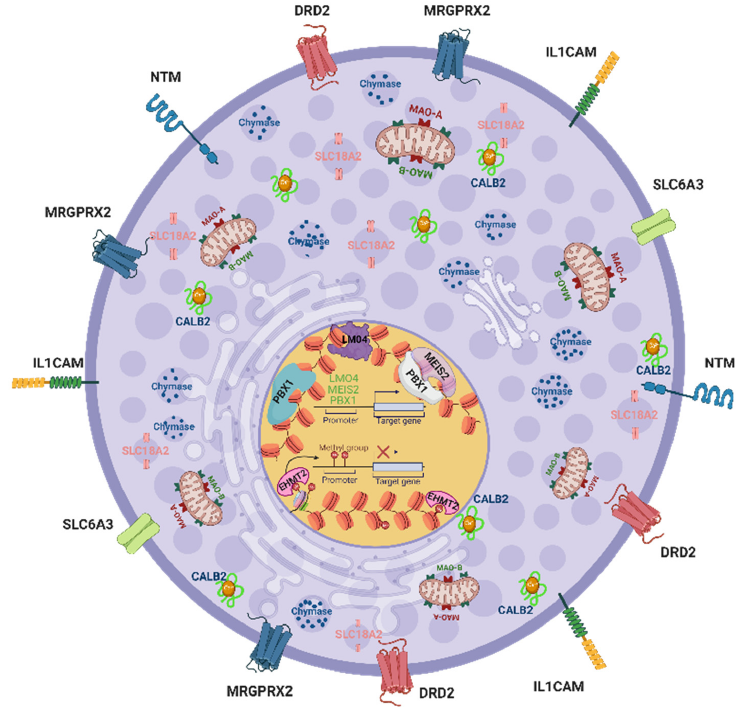
Figure 2. The nervous system-related genes covered in this review. A unifying element is their preferential expression in MCs in comparison to other myeloid cells. Depicted is the principal cellular localization of the following entities: DRD2, MAOA, MAOB, SLC18A2, SLC6A3, MLPH, RAB27B, RAB37, CALB2, L1CAM, NTM, LMO4, PBX1, MEIS2, and EHMT2. The genes MC chymase (CMA1) and MRGPRX2, expressed only by MCs and not by other constituents of the body (according to the com- prehensive FANTOM5 atlas), have been added for comparison. Abbreviations: CALB2 (Calbindin 2 or Calretinin), DRD2 (Dopamine Receptor D2), EHMT2 (Histone-lysine N-methyltransferase), L1CAM (Neural cell adhesion molecule L1), LMO4 (LIM domain transcription factor 4), MAOA (Amine oxi- dase (flavin-containing) A), MAOB (Amine oxidase (flavin-containing) B), MEIS2 (Myeloid-Ecotropic Viral Integration Site 1 Homolog 2), MRGPRX2 (Mas-related G-protein-coupled receptor member X2), NTM (Neurotrimin), PBX1 (Pre-B-cell leukemia transcription factor 1), SLC18A2 (Synaptic vesicular amine transporter), and SLC6A3 (Sodium-dependent dopamine